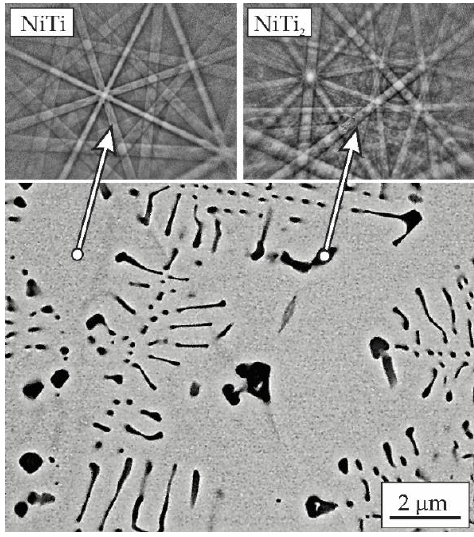
concentration of carbon, below the detection limit of the method. In spite of the iron-content, no